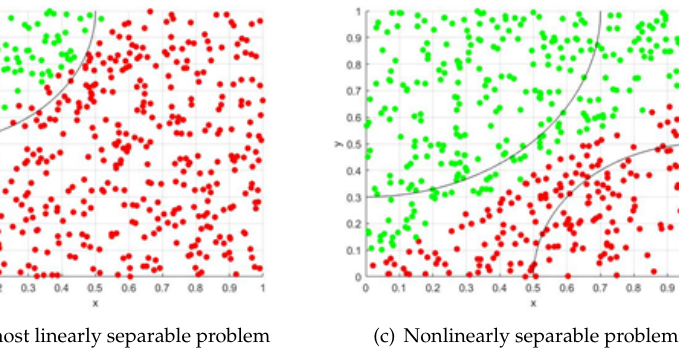
Figure 6. Single-layer